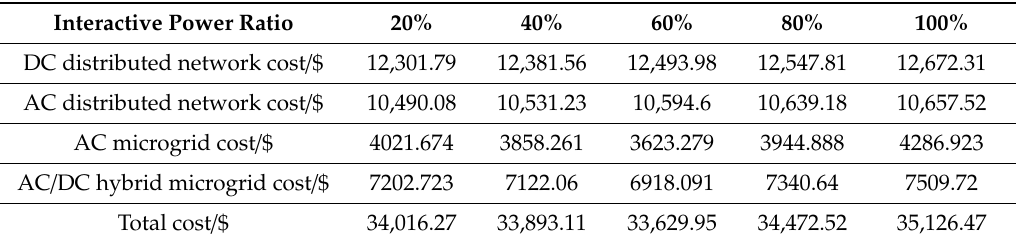
Table 7. Cost calculation results under di ff erent interactive power